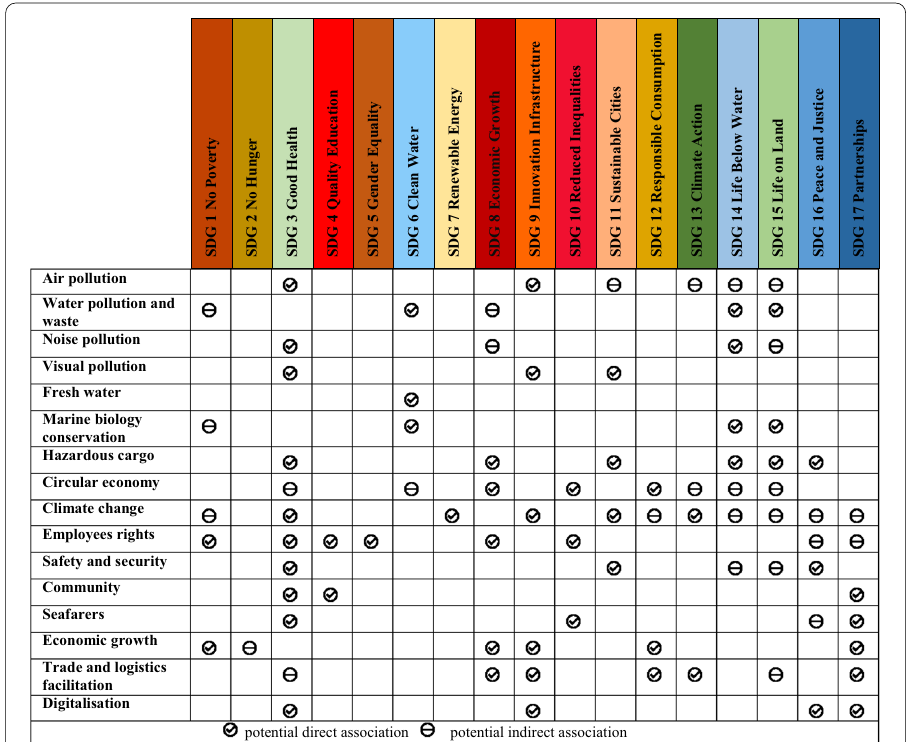
Fig. 6 Potential linkage between port sustainability actions (first column) and UN SDGs (first row). Source : Authors’